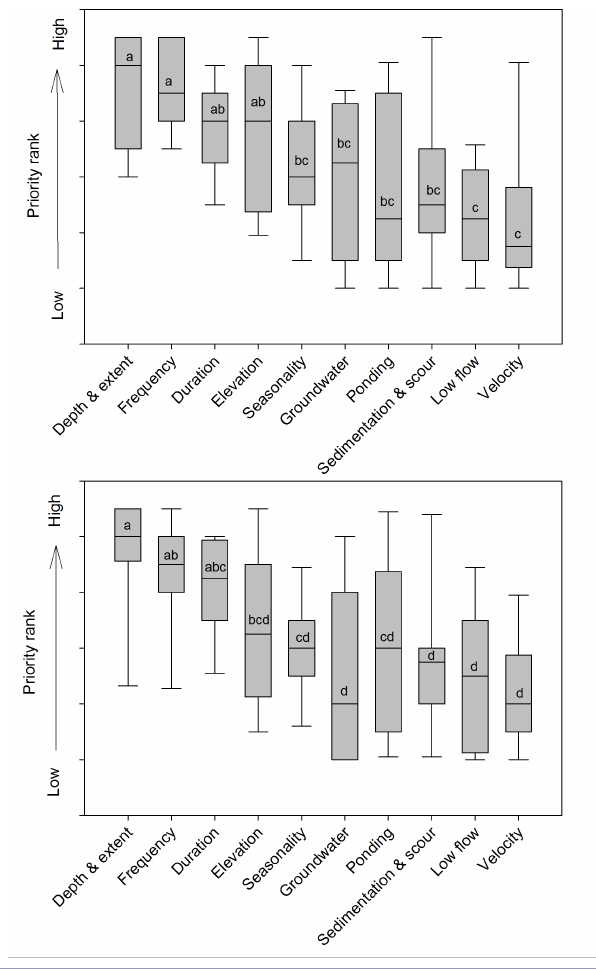
Fig. 5 . Boxplots of rankings from 21 respondents to the follow- up survey on the development priority of various